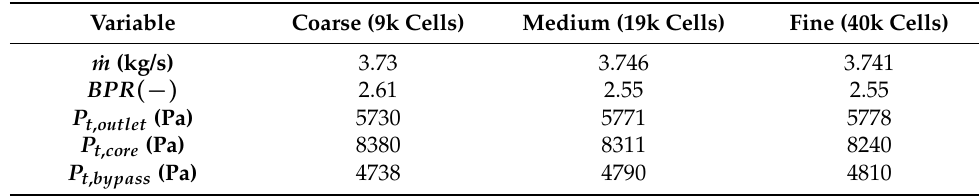
Table 2. Independence of the 2D